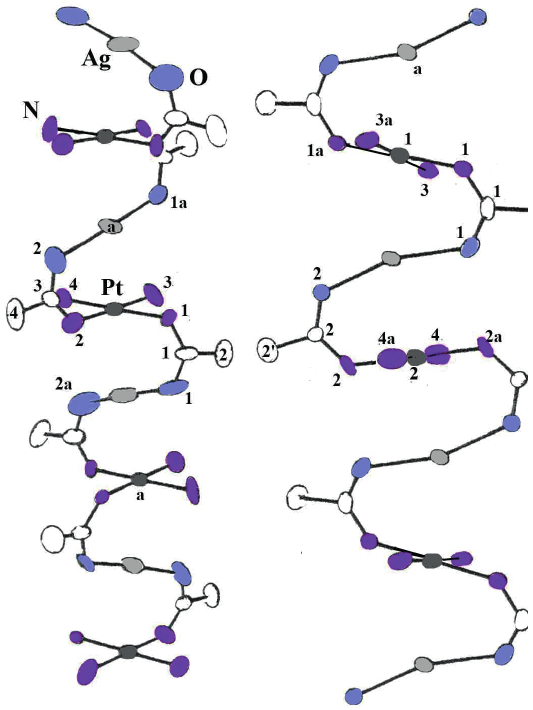
) Pt(NHCOMe) Ag] + 3 2 2